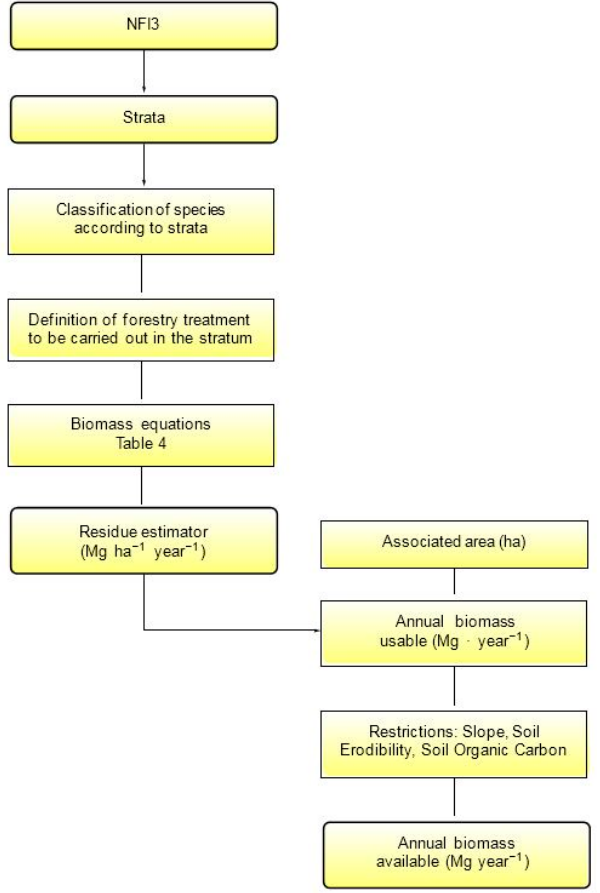
Figure 4. Schematic diagram of the method followed to determine the available residual biomass.